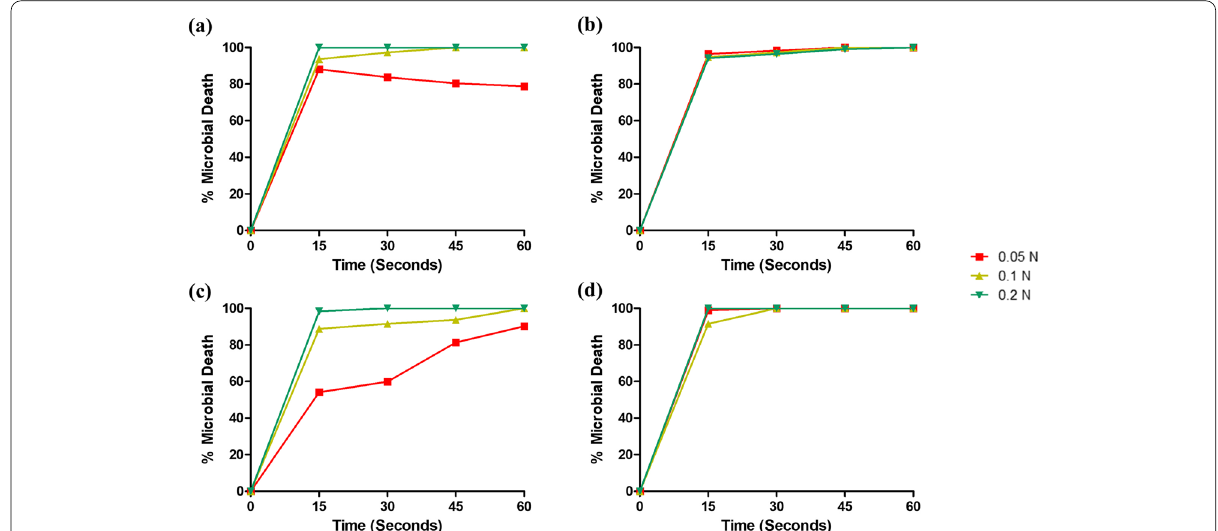
S.D.) recorded by freshly prepared alcoholic ±